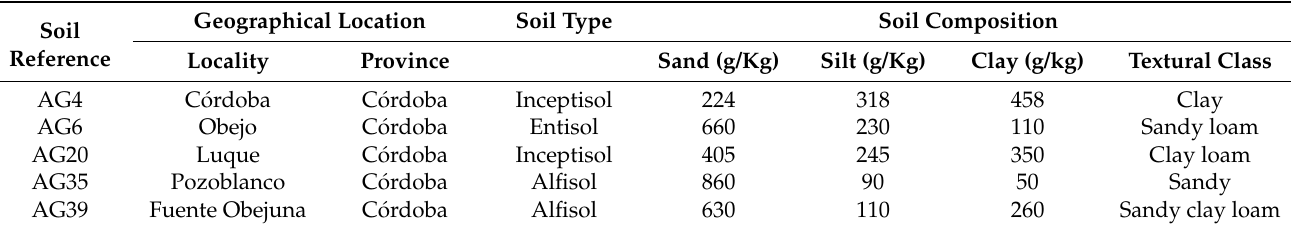
Table 2. Geographical location and properties of the soil samples